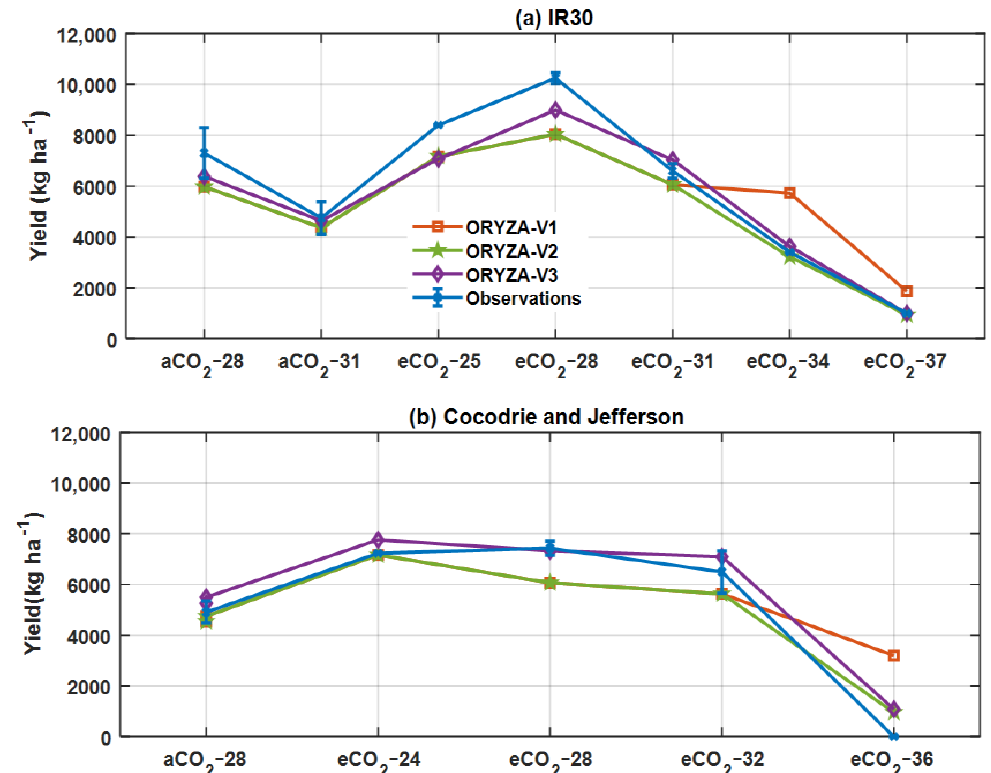
Figure 1. Observed and simulated response of grain yield from three model versions versus daily temperature value under ambient (aCO 2 ) or elevated (eCO 2 ) CO 2 for cultivars ( a ) IR30 and ( b ) Cocodrie and Jefferson using data from Table 2. Observed and simulated means for Cocodrie and Jefferson were shown as averages across varieties due to very small yield differences.